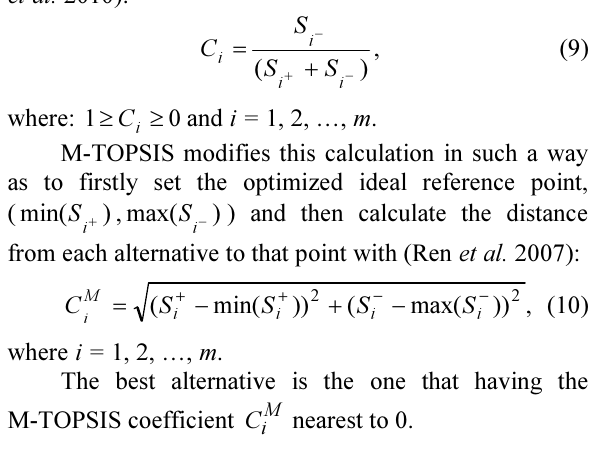
F 3 : quality performance = actual costs of elimination of complaints/budgeted cost; F 4 : safety performance = no. of right observations/ total no. of safety issue